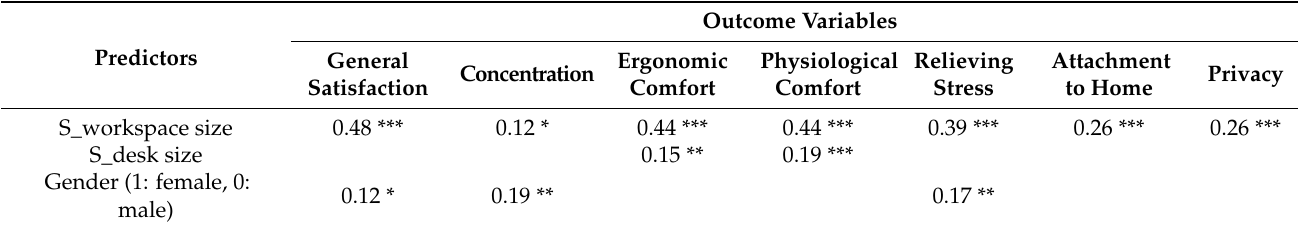
Table A1. Regression models (Beta coefficients) predicting ratings for the home